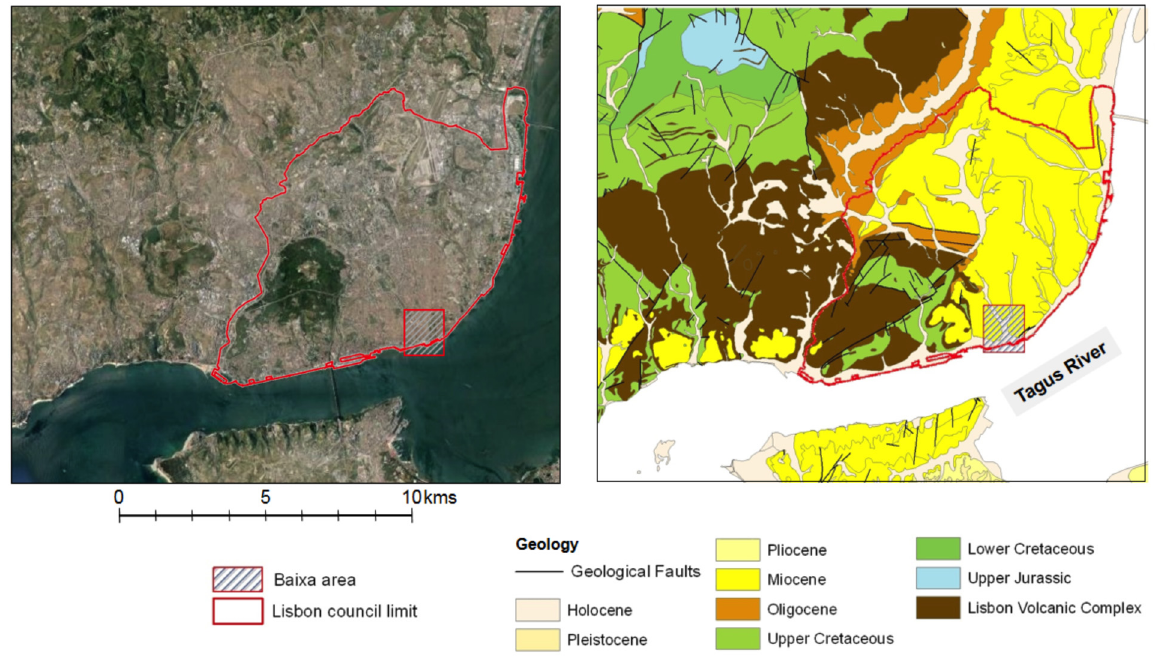
Figure 1. Location of the Lisbon City Council boundary and the Baixa area. Left: Aerial view from Google Earth. Right: Geological map of Lisbon and the surrounding area (adapted from the 1:100,000 Lisbon Metropolitan Area geological